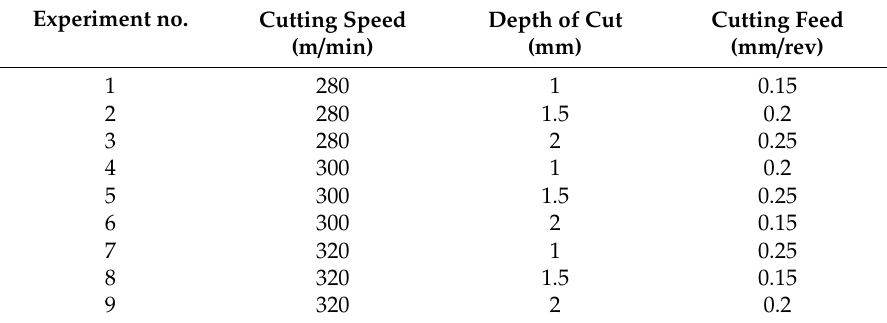
Table 2. Orthogonal array machining experiment